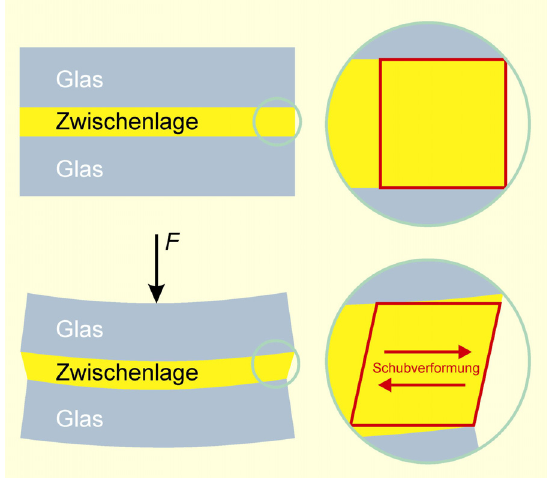
Figure 1: Effect under bending